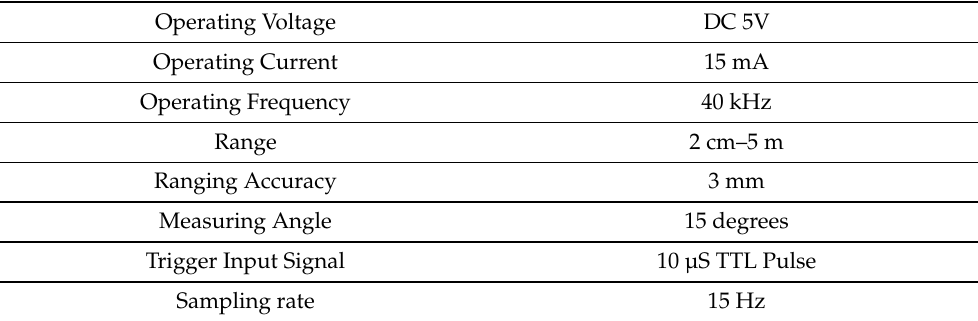
Figure 7. Component layout of IOAM wearable devices ( a ) and data transmission schematic during the experiment ( b ). Table 2. Specifications of HC-SR04 ultrasound